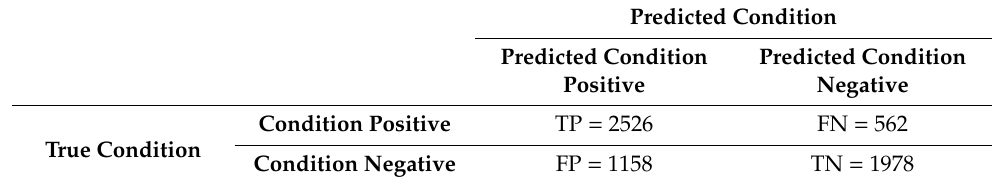
Table 9. Confusion matrix for XGB. (TP: true positive, TN: true negative, FN: false negative, FP: false positive).